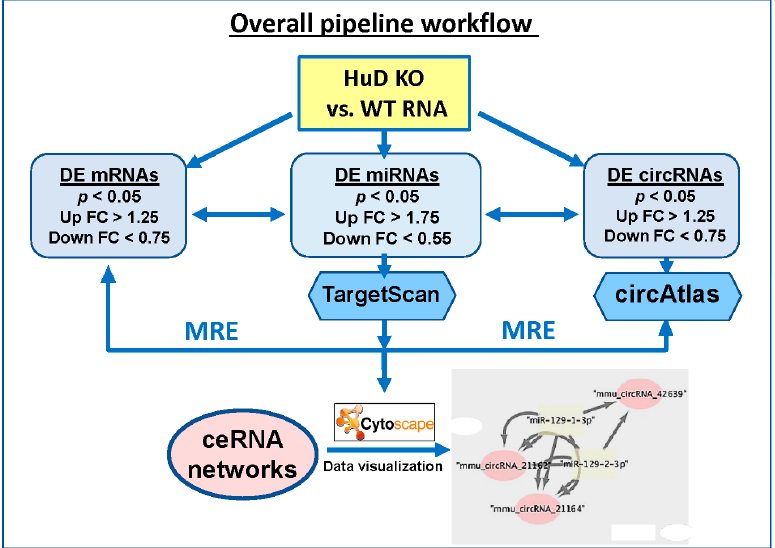
Figure 1. Diagram showing the flowchart of the analysis pipeline used to identify ceRNA networks of differentially expressed (DE) mRNAs, circRNAs, and miRNAs in HuD KO mouse striatum (STR). The list of mRNAs significantly downregulated in HuD KO mice was compared with those of upregulated miRNAs and downregulated circRNAs. A second analysis compared the set of upregulated mRNAs with those of downregulated miRNAs and upregulated circRNAs. See Methods and Figure S1 for more details on the analyses and network visualization using Cytoscape. MRE: miRNA recognition element.